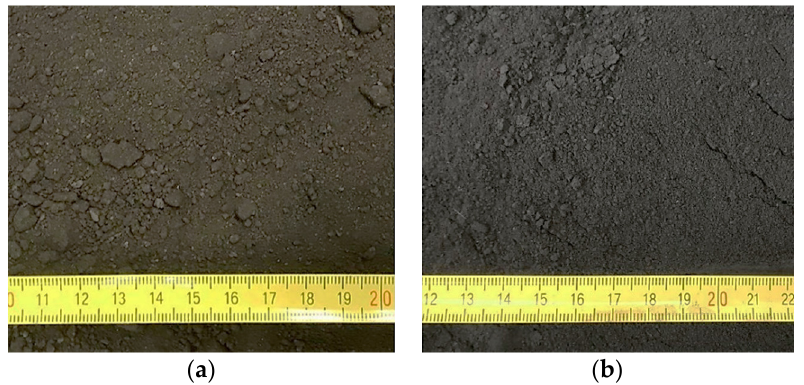
Figure 2. ( a ) Used foundry sand (UFS) and ( b ) gasification char (GCH) before grinding and sieving processes